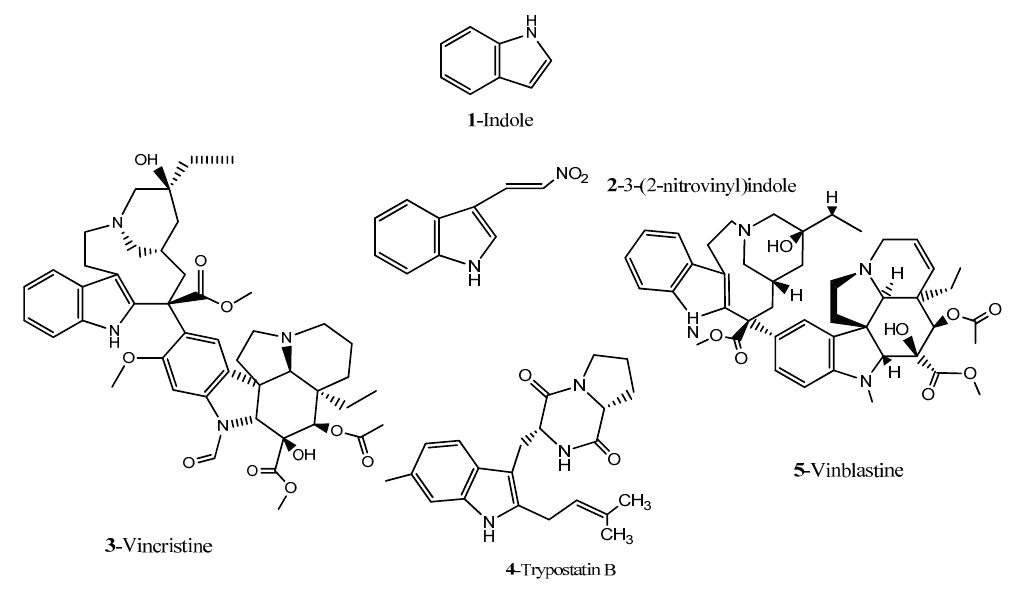
Figure 2. Chemical structure representation of indole basic core structure and of reported/FDA approved examples of indole like compounds as tubulin inhibitors